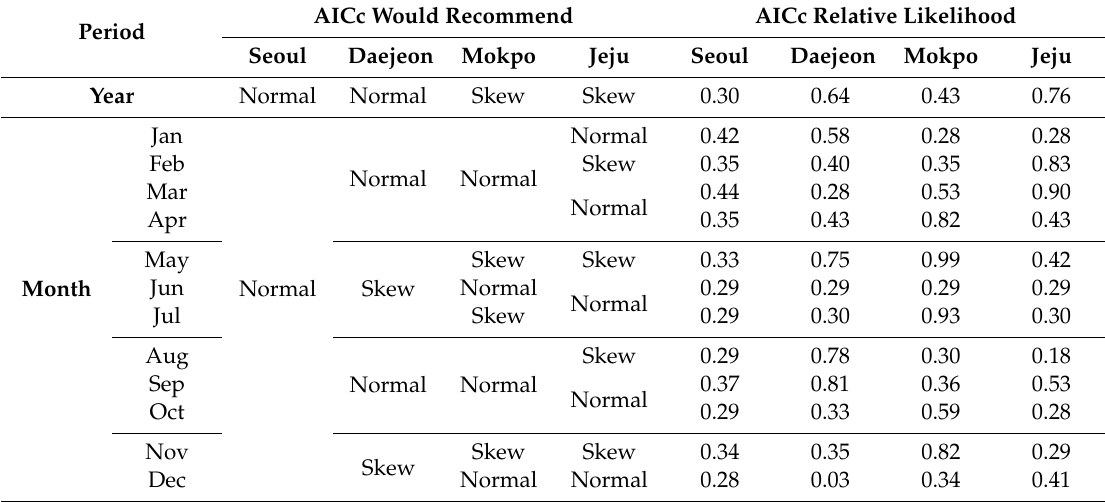
Table 4. Distributions of four cities.